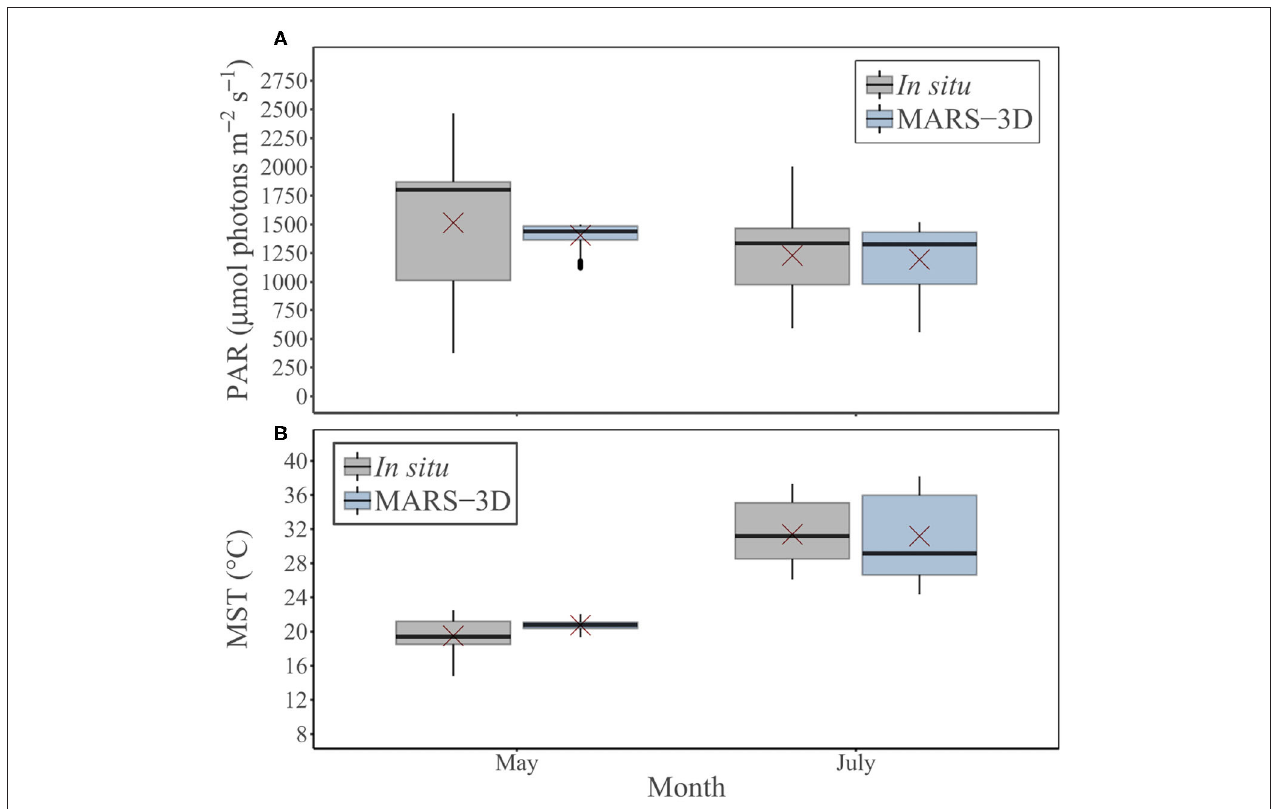
FIGURE 3 | Measured and simulated (A) PAR ( µ mol photons m − 2 s − 1 ) and (B) MST ( ◦ C) by MARS-3D during in situ sampling days in May and July 2015. Red crosses correspond the mean value of PAR and MST for the corresponding period.